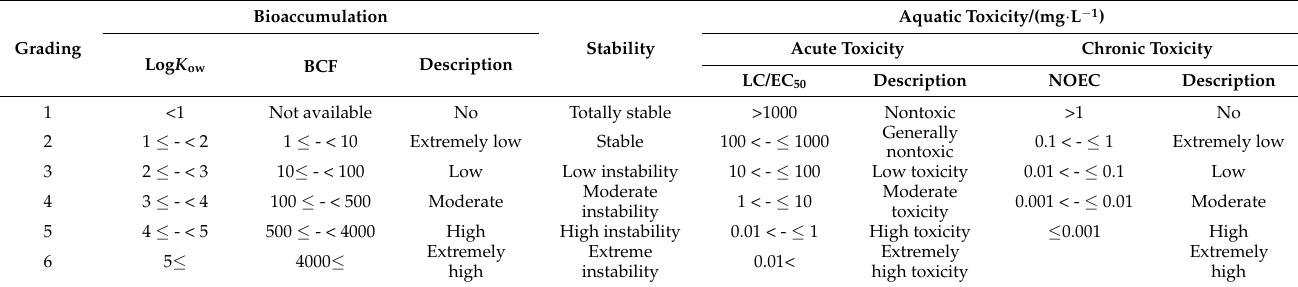
Table 1. Grading standard for ecological toxicities of dangerous chemicals of